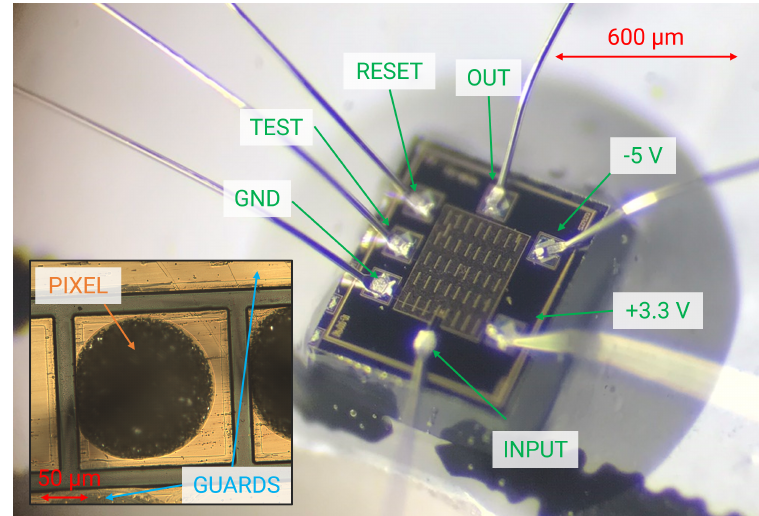
Figure 3. Micrograph of a SIRIO charge sensitive preamplifier (650 × 600 µm 2 ) with the bonding-pad pinout. In the inset, a detail of a CZT pixel wire bonded to the preamplifier using a small drop of conductive glue (dark brown